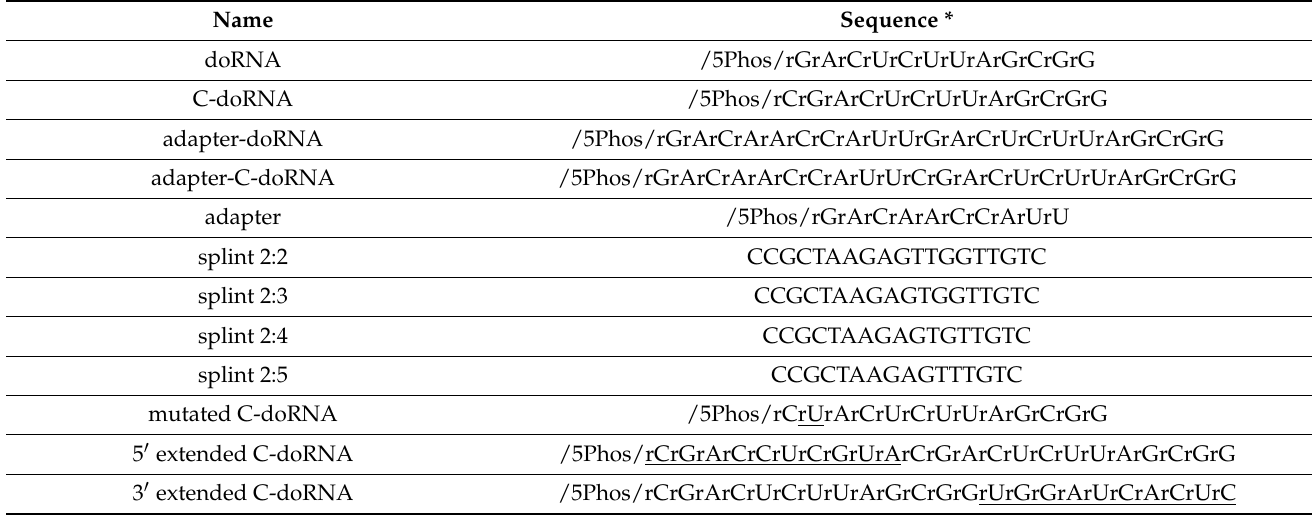
Table 1. RNA and DNA oligonucleotides used in this